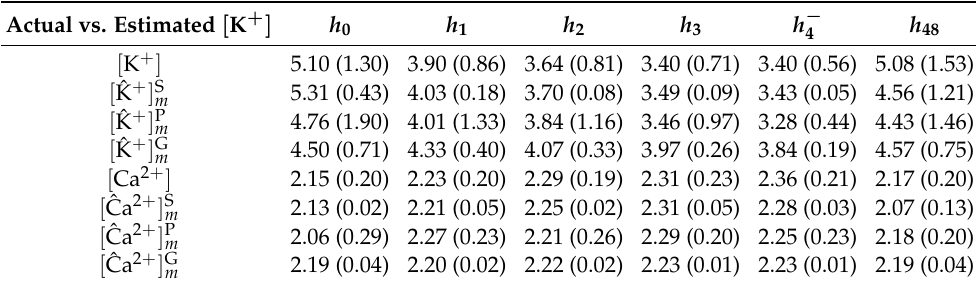
Table 3. Actual and estimated [ K + ] and [ Ca 2 + ] values over the study population at each HD stage us- ing multivariable (m) estimation and stage-specific (S), patient-specific (P) and global (G) approaches. Values are expressed as median (IQR) and the units are mM.